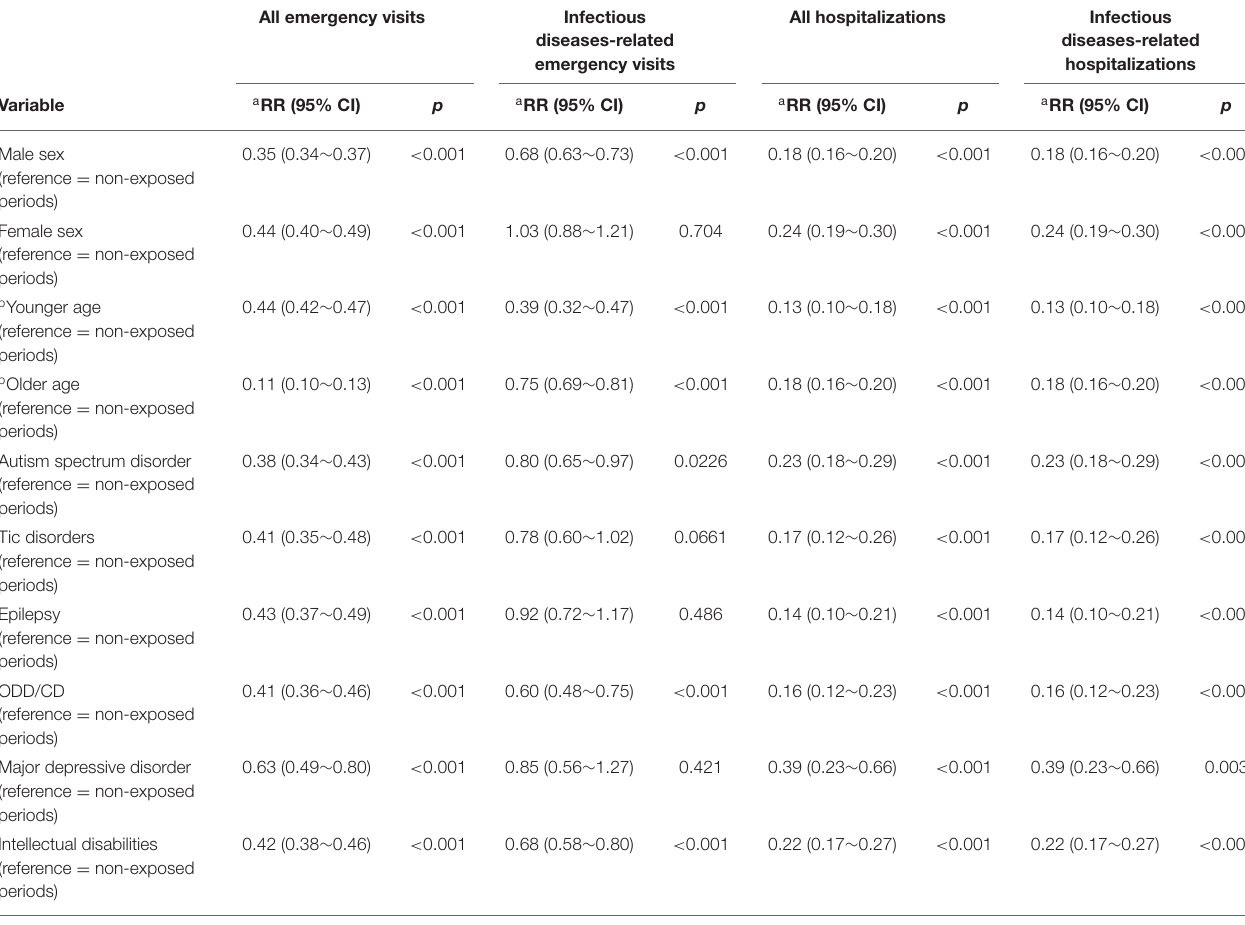
TABLE 5 | SCCS model use of methylphenidate of on hospitalizations and emergency room visits in ADHD youth stratified by demographic variables and